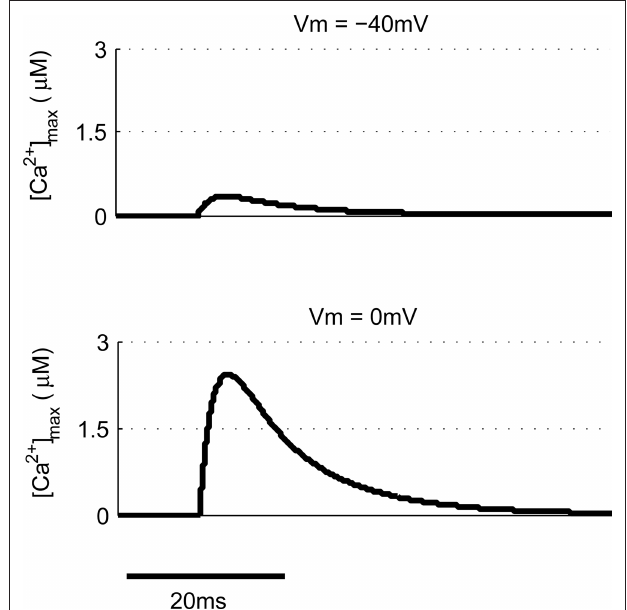
Figure 6 | Post-synaptic voltage clamp paired with pre-synaptic stimulation determines spine [Ca 2 + ]. The model predicts that voltage clamp of the post-synaptic membrane potential at − 40 mV produces a much smaller spine [Ca 2 + ] than 0 mV when paired with a single pre-synaptic